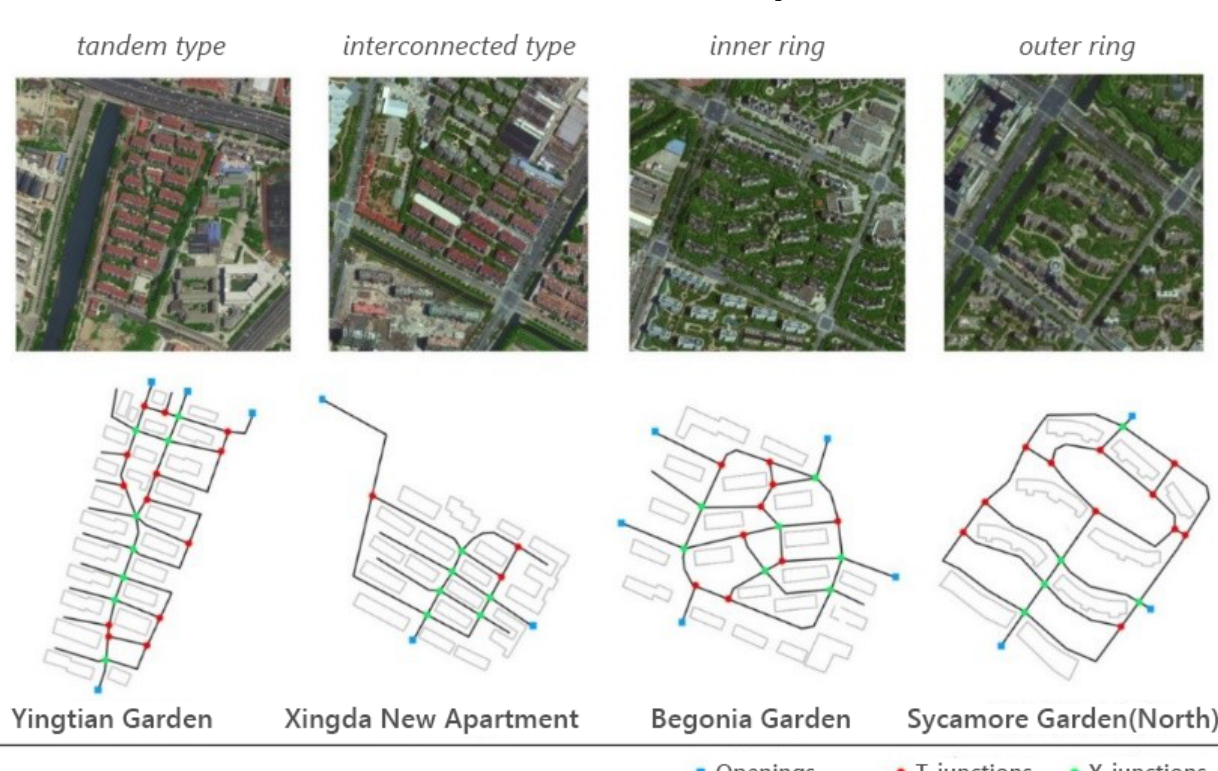
Figure 1. Schematic plot of road network extraction in residential areas.